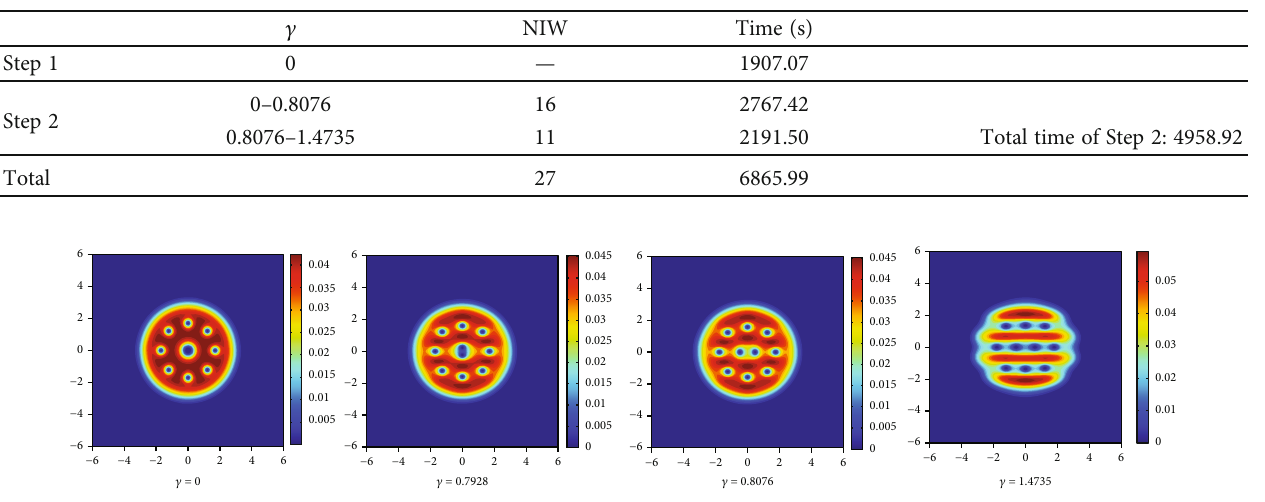
Figure 7: The contours of the ground state density function j ϕ j 2 of (15), where V ffiffiffi ffiffiffi p p ε = 1/ 5 , n = ð 1,0,1 Þ / 2 , ω = 1 : 9 , β = 500 , and λ = γβ